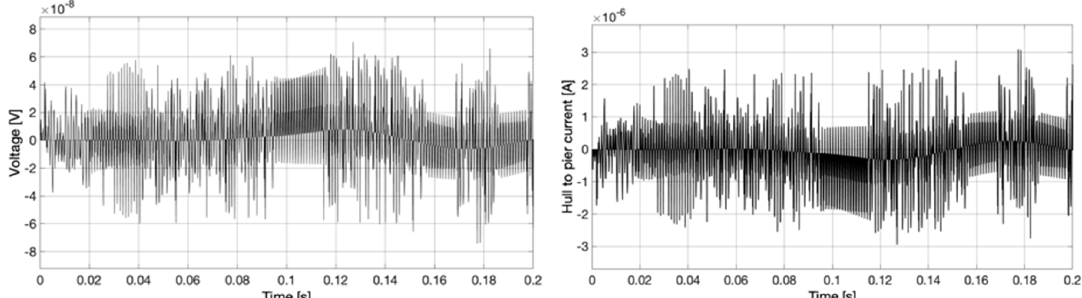
Figure 9. Simulink Model #1 numerical experiments results for symmetrical capacitances (0.030 µ F per phase shore line), symmetrical supply voltages and stray current path resistance equaling 0.024 ohms. Hull—pier voltage ( left ), stray current waveform ( right ).